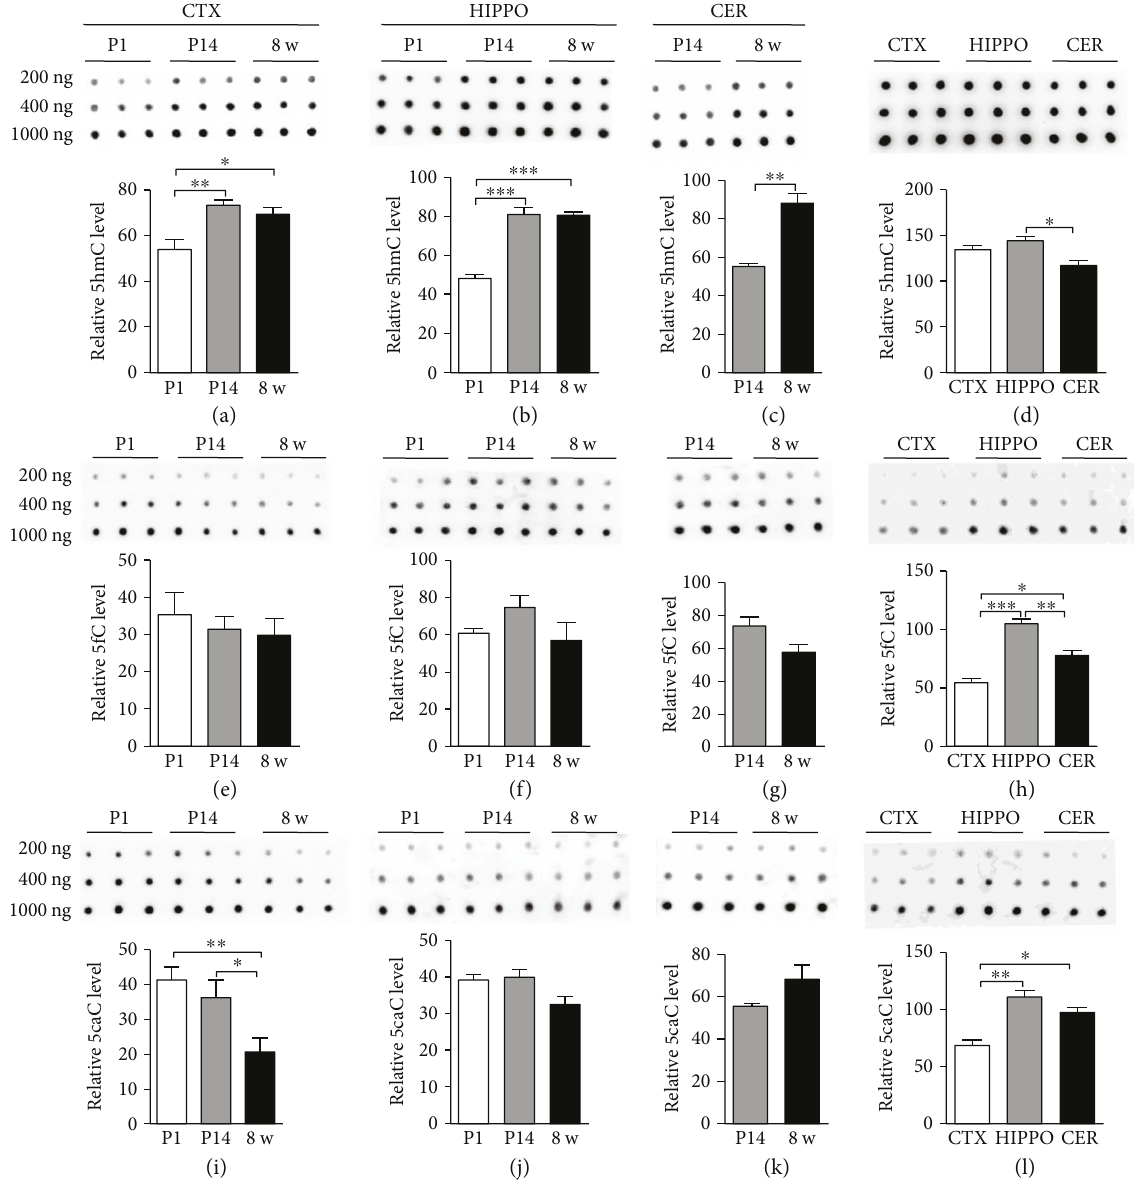
Figure 2: 5hmC, 5fC, and 5caC in di ff erent brain regions using DNA dot blot. The relative levels of 5hmC, 5fC, and 5caC in the P1, P14, and 8w cortex ((a), (e), (i)), hippocampus ((b), (f), (j)), and cerebellum ((c), (g), (k)). Comparison of 5hmC (d), 5fC (h), and 5caC (l) levels between di ff erent brain regions at 8w. Data are represented as mean ± SEM ( n = 3 ). Statistically signi fi cant di ff erences were indicated: ∗ p < 0 05 , ∗∗ p < 0 01 , and ∗∗∗ p < 0 001